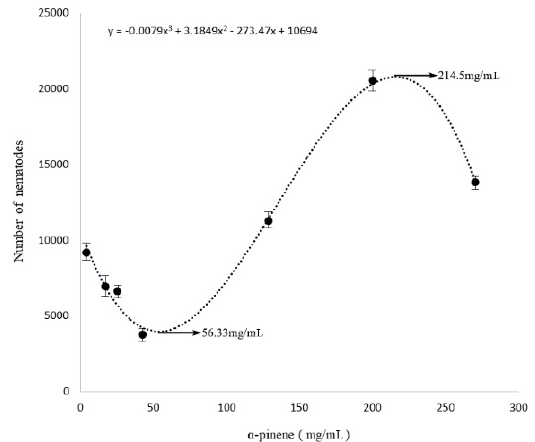
Figure 3. PWN population quantity as affected by α -pinene concentration. The points represent the number of nematodes. The line represents the best fit of the data. There were three biological replications for each experiment. The error line means standard deviation of the mean.